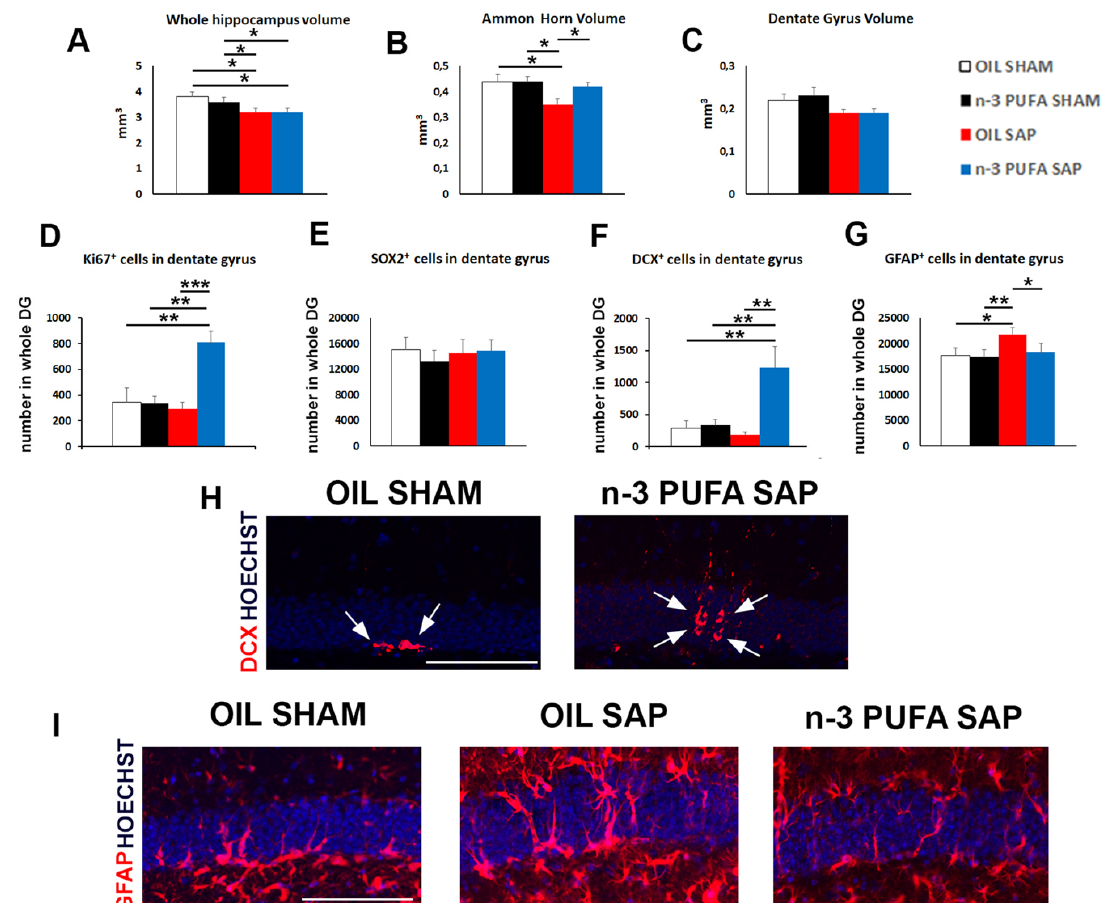
Figure 5. Morphological results. ( A – C ). Diagrams showing the variations of volume in the whole hippocampus, Ammon’s Horn (CA1 + CA3) and Dentate Gyrus (DG) in the four experimental groups (n = 5 mice / group). ( D ). Graph showing the large increase of Ki67-positive neuroblasts in the n-3 PUFA sap group in respect to the other groups. ( E ). Graph representing the unchanged values detected in the SOX2 + sub-populations. ( F ). Diagram showing the enhancement of DCX-positive neuroblasts in the n-3 PUFA sap group in respect to the other groups. ( G ). Histogram indicating the GFAP + cell number in the DG. ( H ). Representative images showing the increase in the DCX + cells (red, arrows) in the DG of the n-3 PUFA sap mice, when compared with oil sham group. ( I ). Representative fluorescence images of GFAP + cells (red), showing the increased astrogliosis in the oil sap group, counteracted by the pre-treatment with n-3 PUFA. Scale bar 100 µ m. * p < 0.05, ** p < 0.01, *** p < 0.001; Student’s t